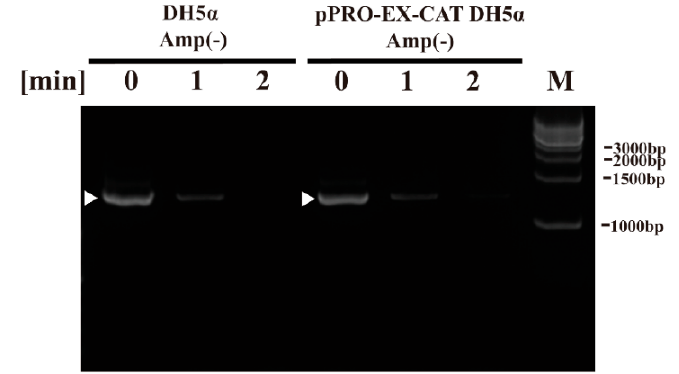
Figure 4. Genomic DNA (16S rDNA) of non-transformed E. coli proliferated in ampicillin-free medium (DH5 α Amp( − )) and E. coli transformed with a plasmid conferring ampicillin resistance, selected in ampicillin-containing agar medium and proliferated in ampicillin-free medium (pPRO-EX-CAT DH5 α Amp( − )), was degraded by DBD plasma torch treatment. A suspension of non-transformed E. coli proliferated in ampicillin-free medium (DH5 α Amp( − )) and E. coli transformed with an ampicillin resistance gene-containing pPRO-EX-CAT plasmid, selected in ampicillin-containing agar medium and proliferated in ampicillin-free liquid medium (pPRO-EX-CAT DH5 α Amp( − )), was exposed to a DBD plasma torch for the indicated time (min). Viable cell count (colony forming units (CFU) / mL) was then determined before and after treatment. Bands corresponding to amplified E. coli 16S rDNA are indicated by arrowheads. Bands corresponding to a DNA size ladder (M) are labelled on the right-hand side of the